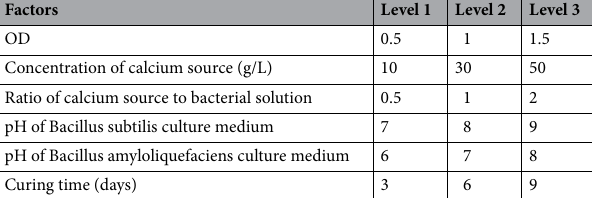
Table 1. List of the optimization factors of each composition.